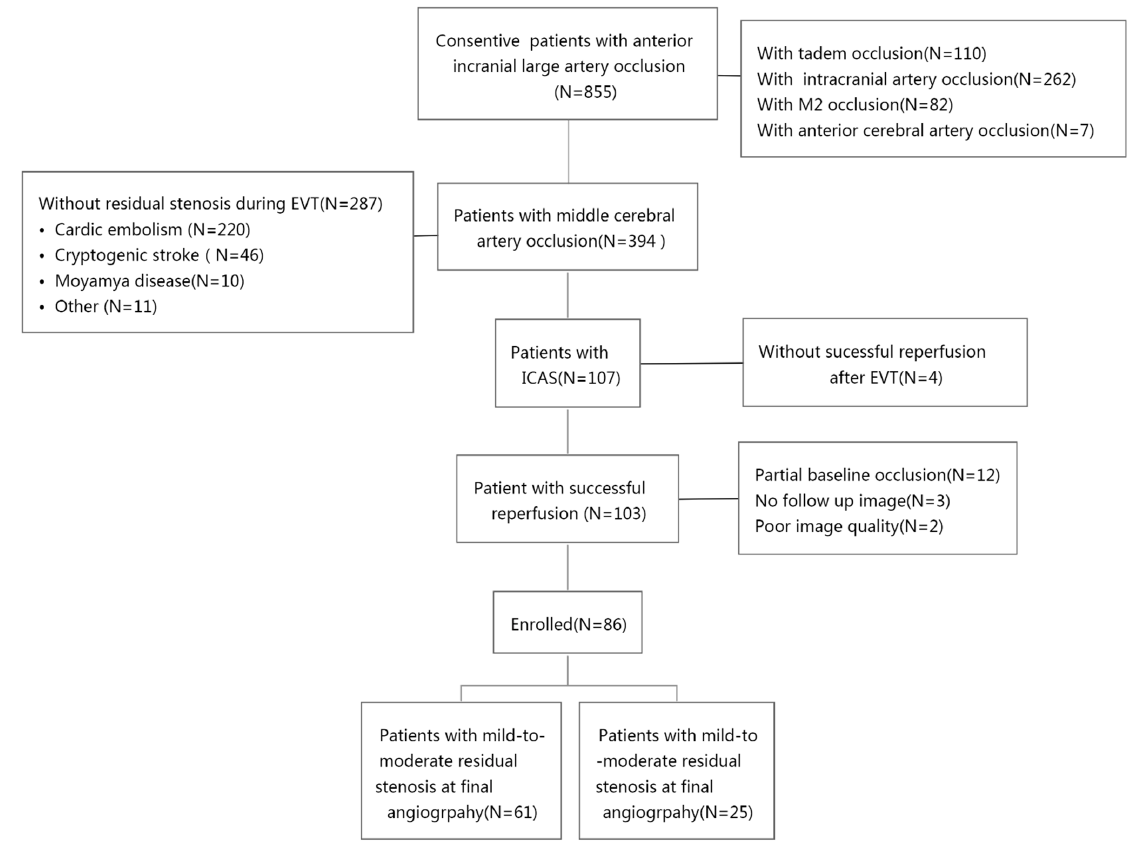
Figure 1. Patient selection and exclusion flow chart.